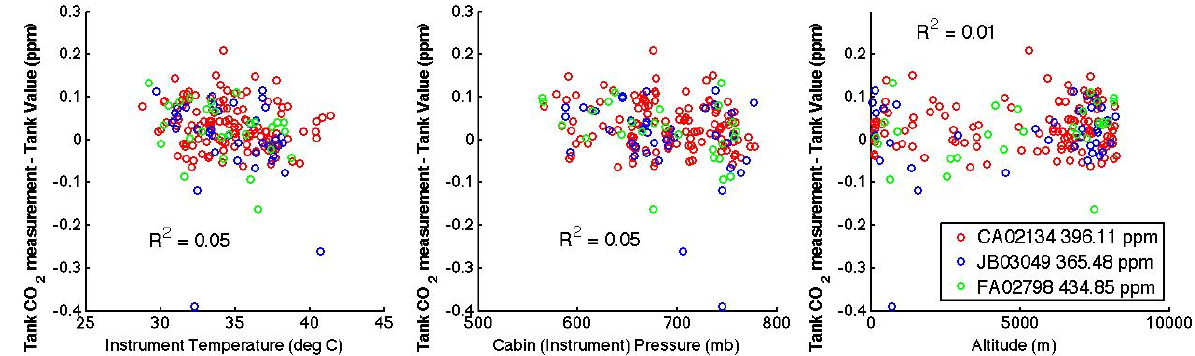
Fig. 8. Measurement of a reference gas tank in 2011, relative to the calibrated tank value, as a function of three environmental variables: instrument temperature (left), cabin pressure (middle), and aircraft altitude (right). Data from all three on-board tanks are shown in differ- ent colors, along with the correlation coefficient ( R 2 ) and equation of a linear fit for each. The measured value is determined using the predeployment laboratory calibration